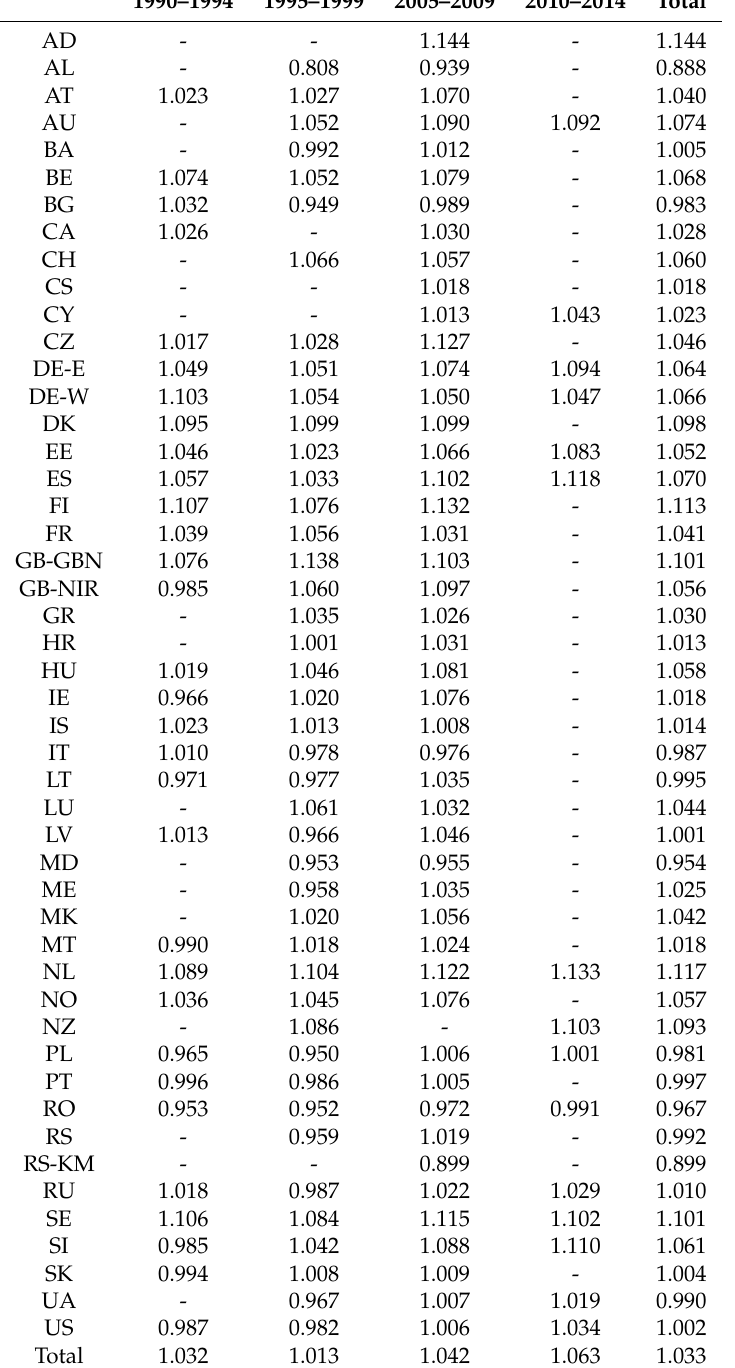
Table A5. The mean of the relative importance of leisure time by country and